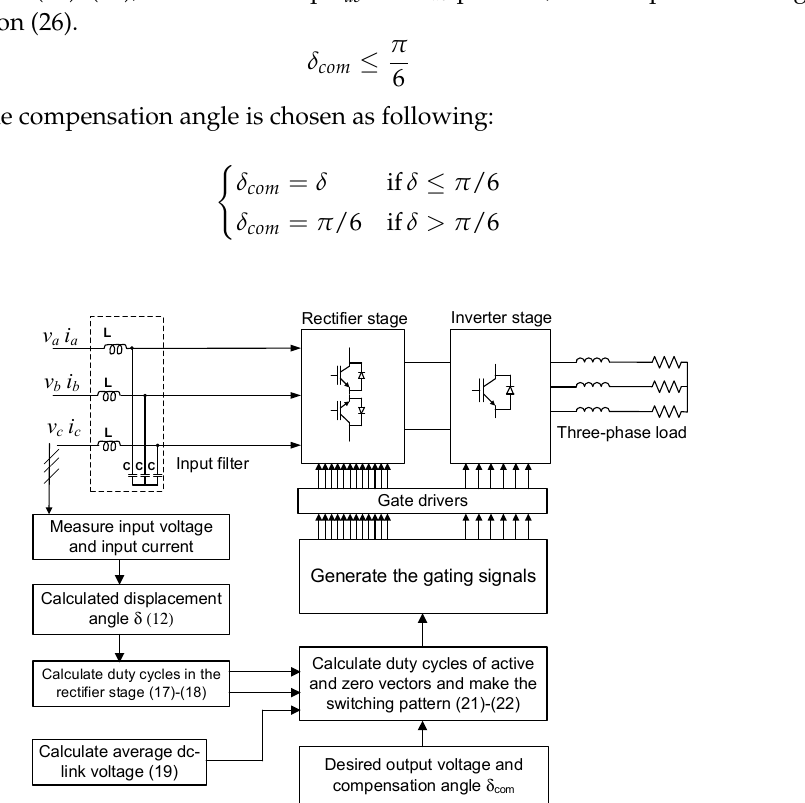
Figure 7. The block diagram of the proposed SVM method.